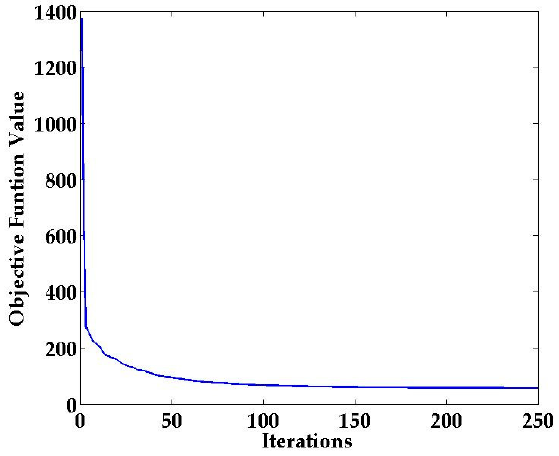
Figure 7. Convergence of the dimensionality reduction algorithm based on locally linear embedding (LLE) and low rank (DRLL).